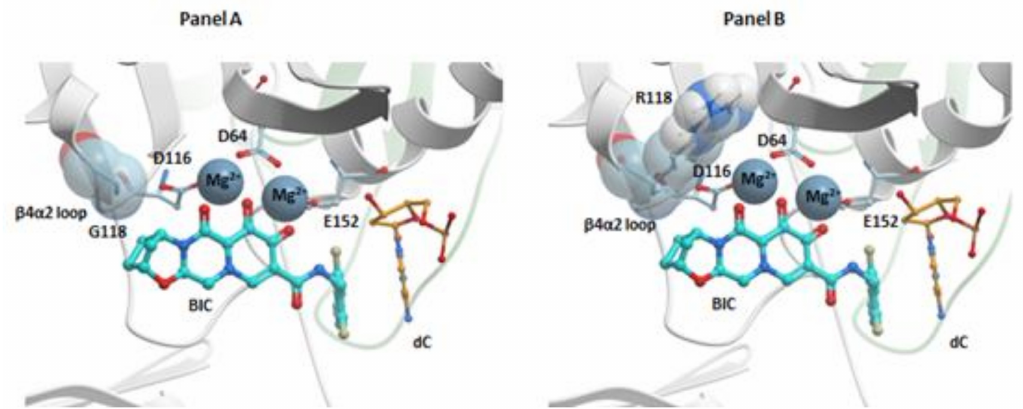
Figure 5. BIC in the active site of the HIV-1 intasome. Panel ( A ): BIC (cyan) is bound in the active site in the HIV-1 intasome. G118 of the β 4 α 2 loop (labeled) is highlighted using a space filled model to reveal the close contact with the “A” ring of BIC. Panel ( B ): BIC (cyan) is shown in the HIV-1 intasome. The mutated amino acid, R118, is shown in a space filling model which shows how this amino acid substitution could disrupt the binding of BIC in the active site of the HIV-1 intasome. In both panels, the catalytic residues are shown and labeled. The penultimate cytosine is labeled and shown in orange, and the Mg 2+ cofactors are gray. The terminal adenine on the 3 (cid:48) end of the viral DNA end is omitted for